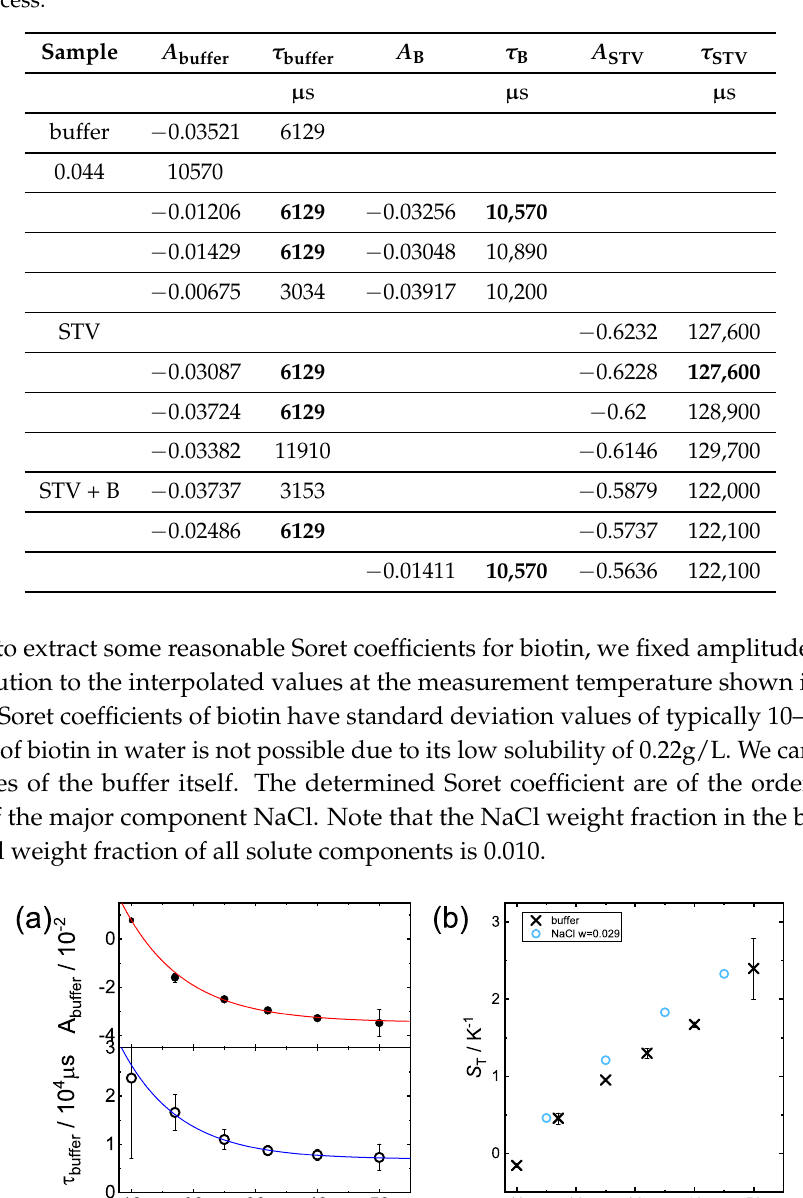
Table A1. As an example the amplitudes and time constants for buffer, B + buffer, STV + Buffer and STV + B-buffer solutions at 35 ◦ C. The parameters in bold print have been fixed during the fitting process.